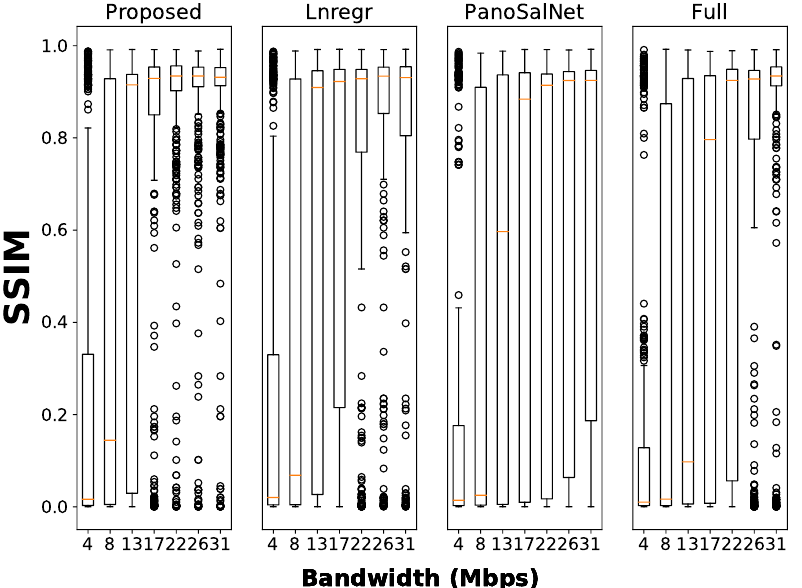
Figure 9. Box plot for users’ Viewport Perceived Quality under different bandwidth conditions. Each bar displays essential statistical information about the dataset, including the median, first quartile, and third quartile values. Outliers are identified by circles positioned above or below each